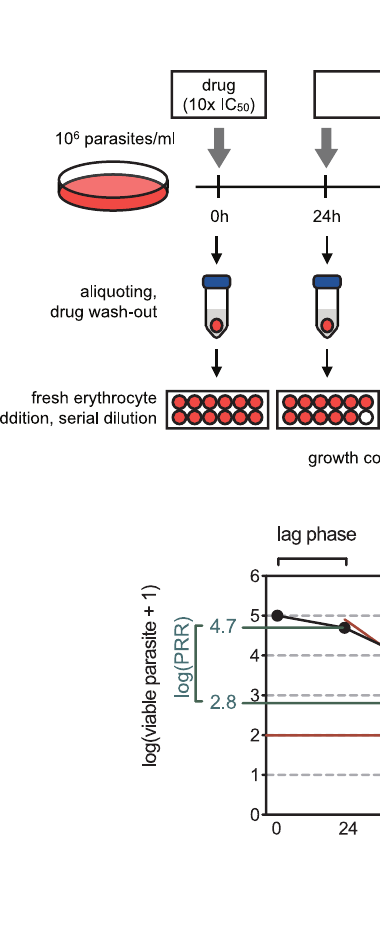
Figure 1. Schematic representation of the invitro PRR assay. A . Intraerythrocytic P. falciparum cultured at 0.5% parasitemia and 2% hematocrit is treated with drugs. The medium is exchanged and the drug replenished every 24 hours. Aliquots corresponding to 10 5 parasites are taken out at defined time points, washed, and free-drug parasites cultured with fresh erythrocytes under limiting serial dilution conditions (see Material and Methods). Parasite growth is subsequently monitored after 21 days and confirmed after 28 days, allowing to calculate the initial number of viable parasite in the aliquot. B . Parasite viability measurement allows in turn to determine the drug lag phase (i.e. time needed to reach the maximal rate of killing), PRR over one life cycle, and 99.9% PCT (i.e. the time needed to decrease the number of viable parasites by 3 –log units). The data presented in this panel are for illustration purpose only. Axe Y shows log (viable parasites + 1) to allow representation of logarithms when counting of number of viable parasites is equal to